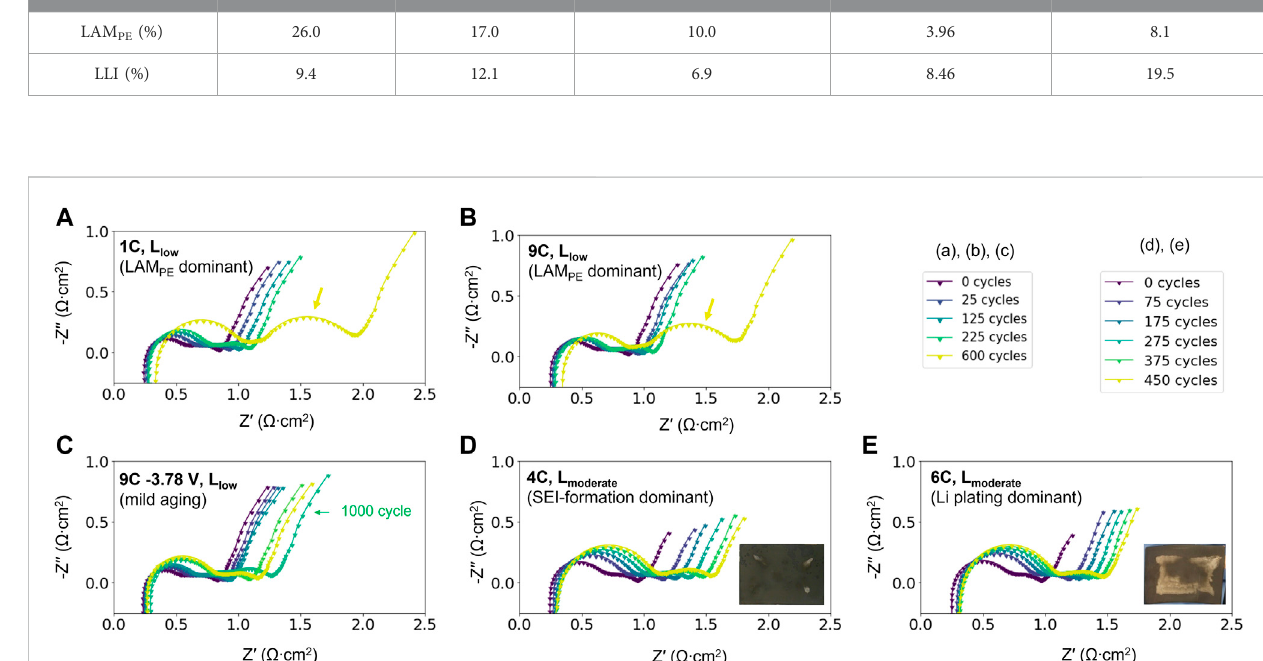
FIGURE 4 EIS trends for representative cell aging behaviors. (A, B) LAM PE dominant case cycled at 1C and 9C, (C) lower LAM PE cycled at 9C but with a lower cutoff voltage, (D) SEI-growth case at 4C with low LLI and LAM, and (E) Li plated case with heavy LLI but less LAM, cycled at 6C. In the LAM PE dominant cases (A,B) ,thesecondarcincreasessigni fi cantlyat600cycles,asindicatedbythearrows.Theinsertedopticalimagesin (D,E) showtheconditionofthe anodes at the end of 450 lifecycles. The metallic gray area is the plated